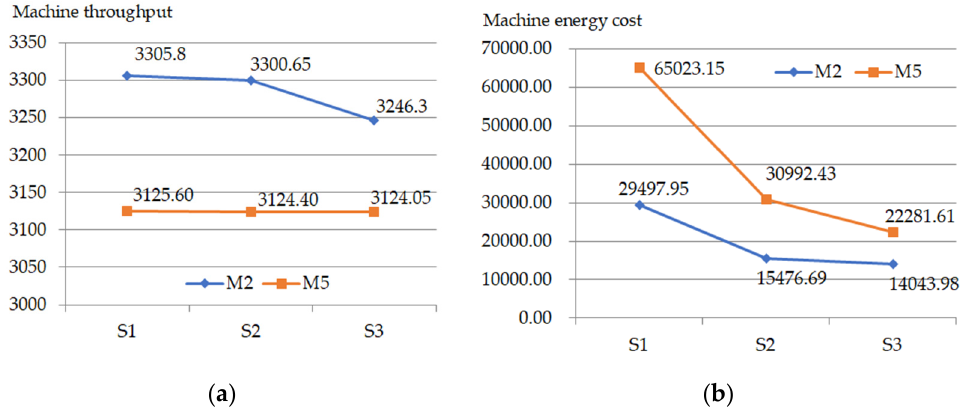
Figure 5. The performances of machine M 2 and M 5 in three scenarios: ( a ) Throughput of machines; ( b ) Energy cost of machines.